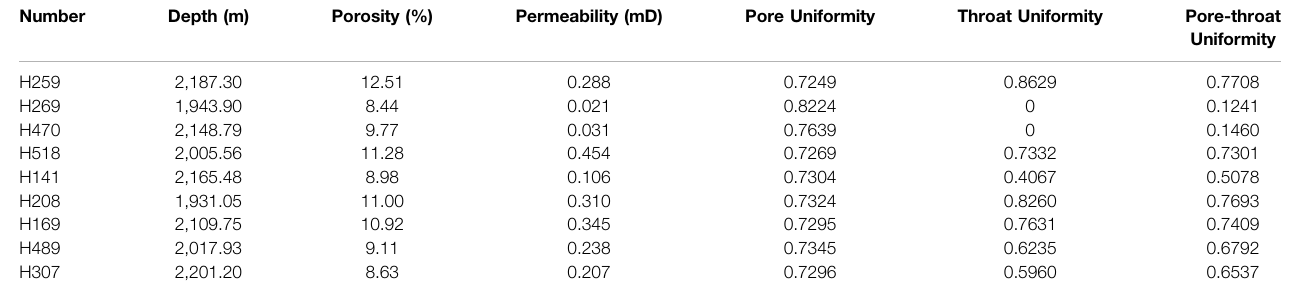
TABLE 1 | Pore-throat uniformity of reservoirs with different types of pore-throat combinations. Number